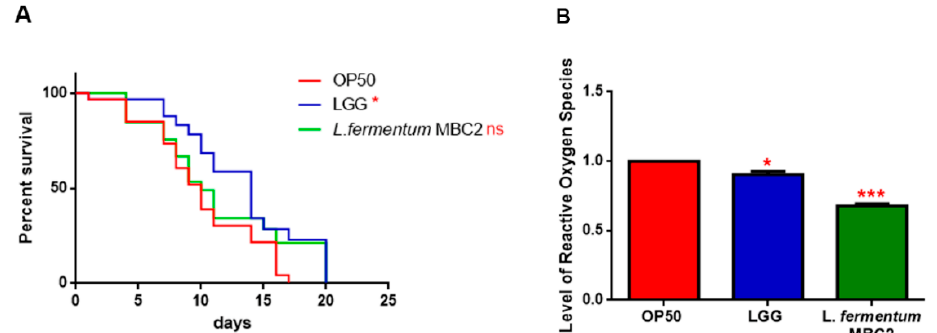
Figure 6. Visualization of lipid droplets in PEPT-1 mutants. BODIPY staining of one and 13 days adult worms grown on OP50 ( A ), LGG (B) or L. fermentum MBC2 ( C ) lawns.